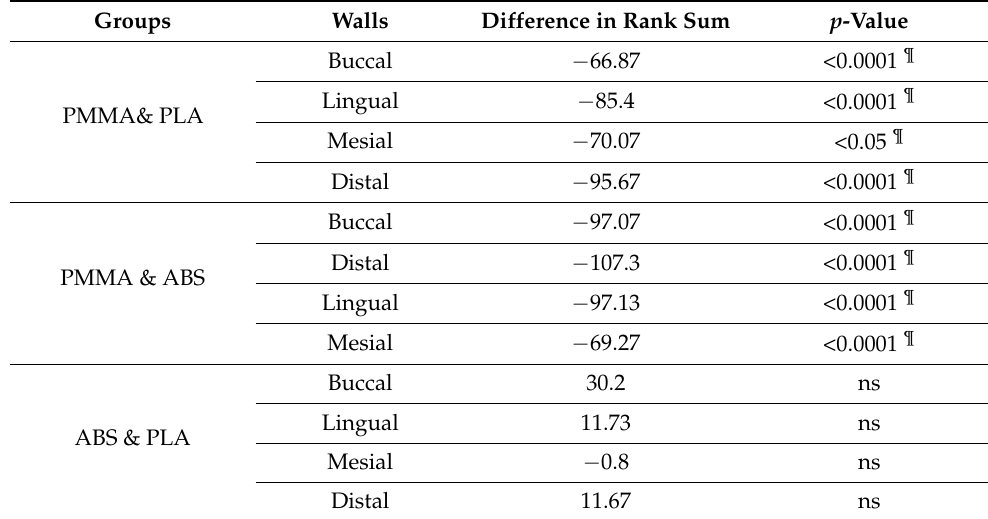
Table 3. Post-hoc Dunn’s multiple comparison test to compare the marginal gap on the four different walls within the groups.